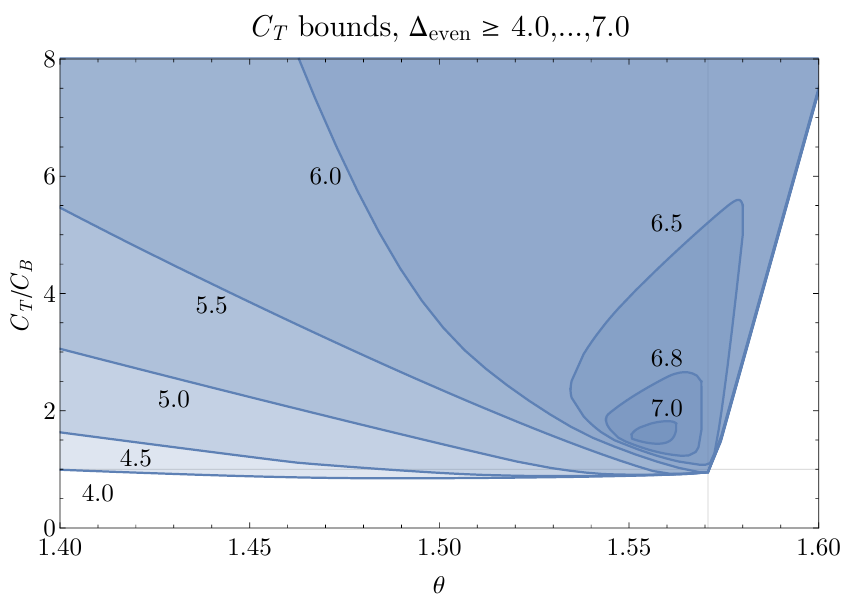
Figure 4 . Bounds on ( (cid:18); C T ) with varying gaps in the parity-even scalar sector. When (cid:1) min 4 : 0 ; : : : ; 6 : 0, we have a series of lower bounds on C T as a function of (cid:18) . When (cid:1) min closed islands which eventually shrink to zero